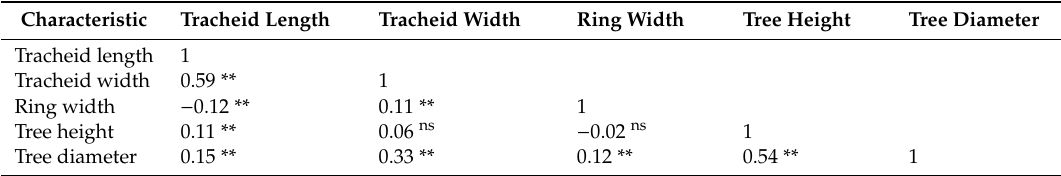
Table 6. Correlation coe ffi cients between tracheid length, tracheid width, ring width, tree diameter and tree height in T. occidentalis and their statistical